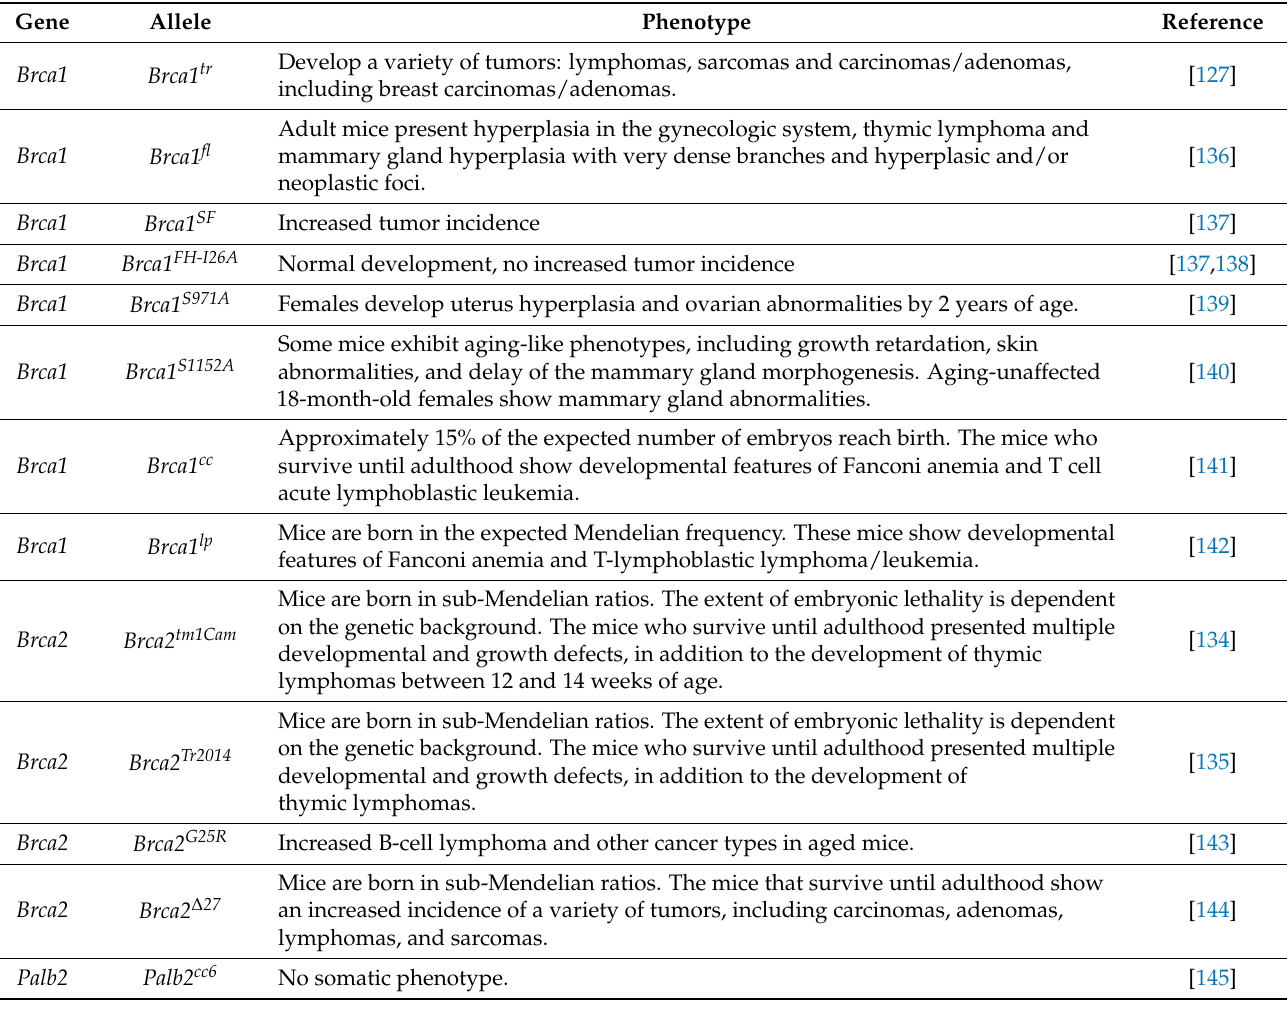
Table 3. Mouse models of partial loss of function of HR genes. Phenotype in homozygotes. Gene Allele Phenotype Reference Brca1 Brca1